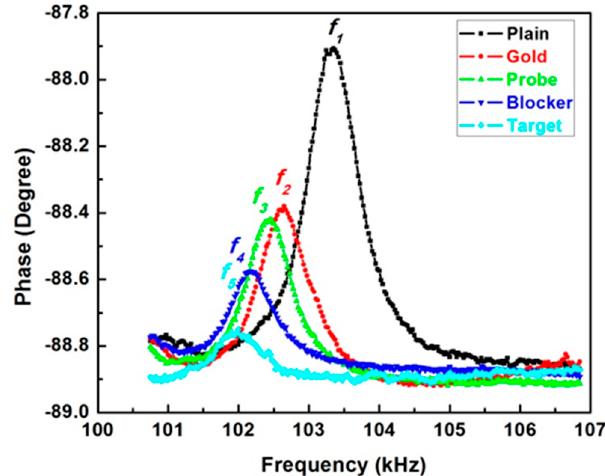
Figure 7. Frequency spectrum of the biosensor after different steps.